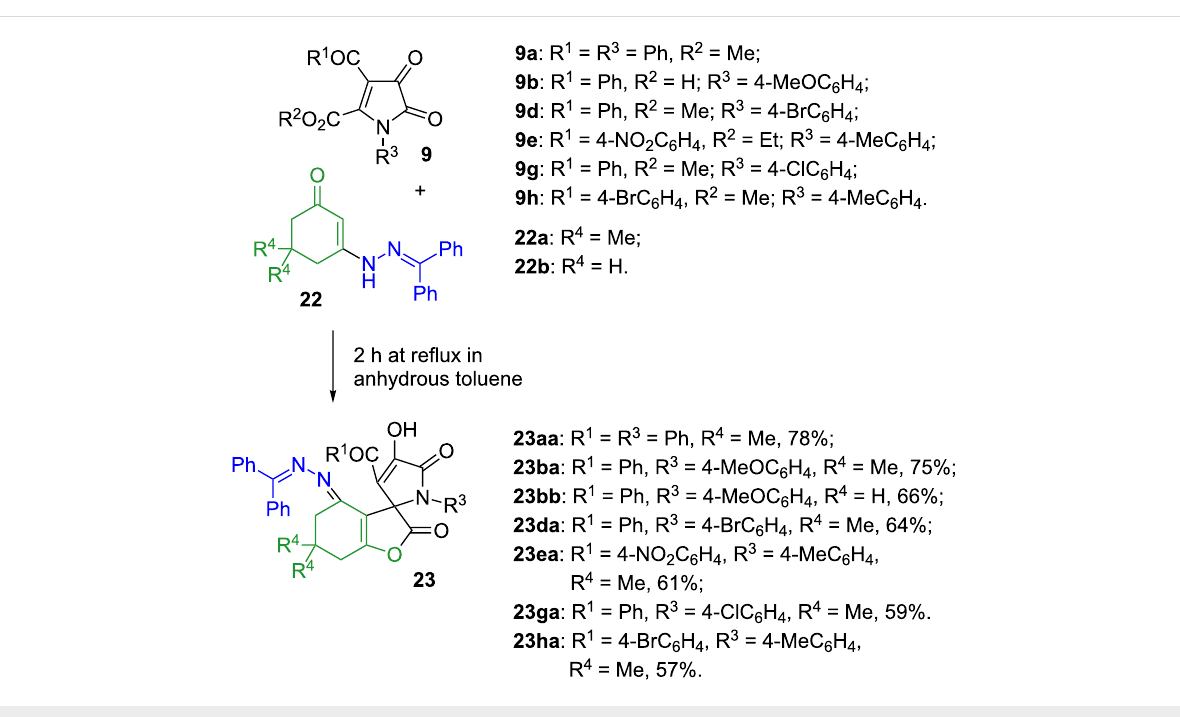
account that, unlike the aforementioned hydrazone structures 15 and 16 , ketazinones appear to be more stable in keto-enamine form 17 .